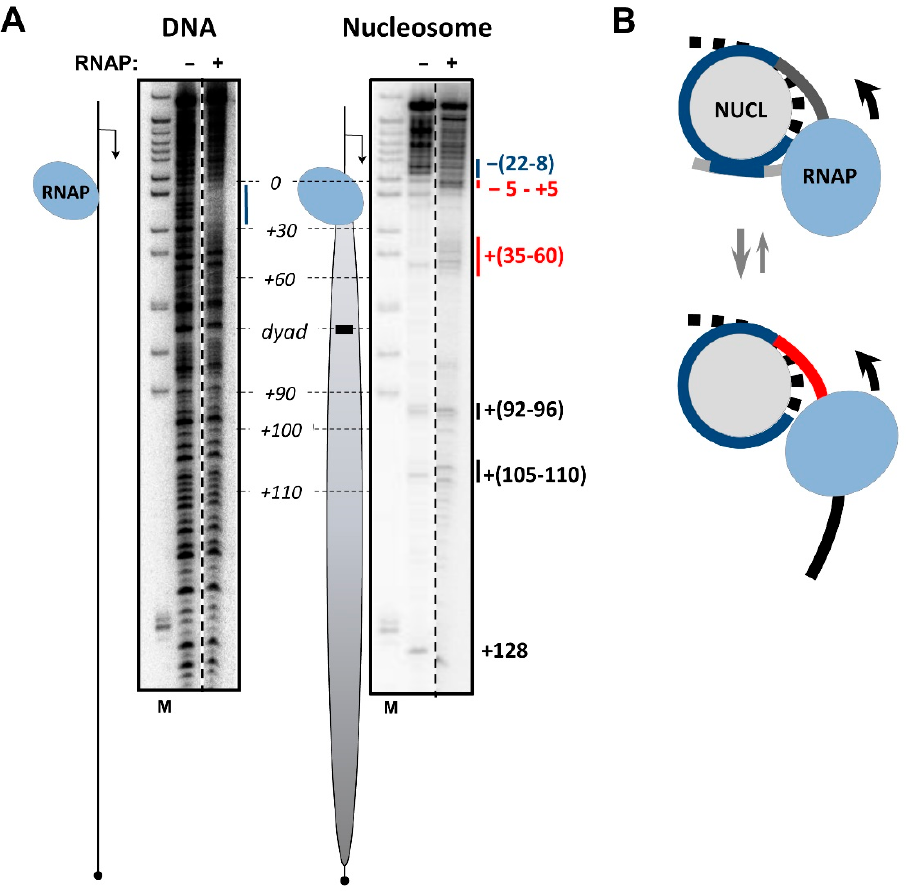
Figure 4. EC+20 containing intact nucleosomal DNA remains mostly in the open state. ( A ) EC+20 were formed on intact DNA or nucleosomes, as described in Figure 1, and analyzed by DNAse I footprinting. Analysis of end-labeled template strand of DNA by denaturing PAGE. Position of the nucleosome on the template is shown by an oval; the direction of transcription is indicated by an arrow. Regions that are either hypersensitive to or protected from DNase I in EC+20 as compared with nucleosomes without EC+20 are shown by red and blue lines, respectively. Changes in the sensitivity of intranucleosomal regions shown by black lines reveal changes in nucleosomal organization downstream the enzyme. ( B ) Schematic drawing of intact EC+20. Linker DNA upstream of RNAP is nearly completely uncoiled from the octamer; the i-loop is only formed on a small fraction of the nucleosomal templates. Region downstream RNAP is partially uncoiled from the histone octamer. Other designations are as in Figure